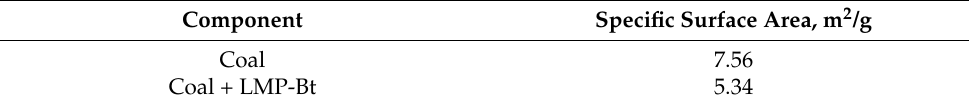
Table 7. Specific surface areas of coal and coal + LMP-Bt.